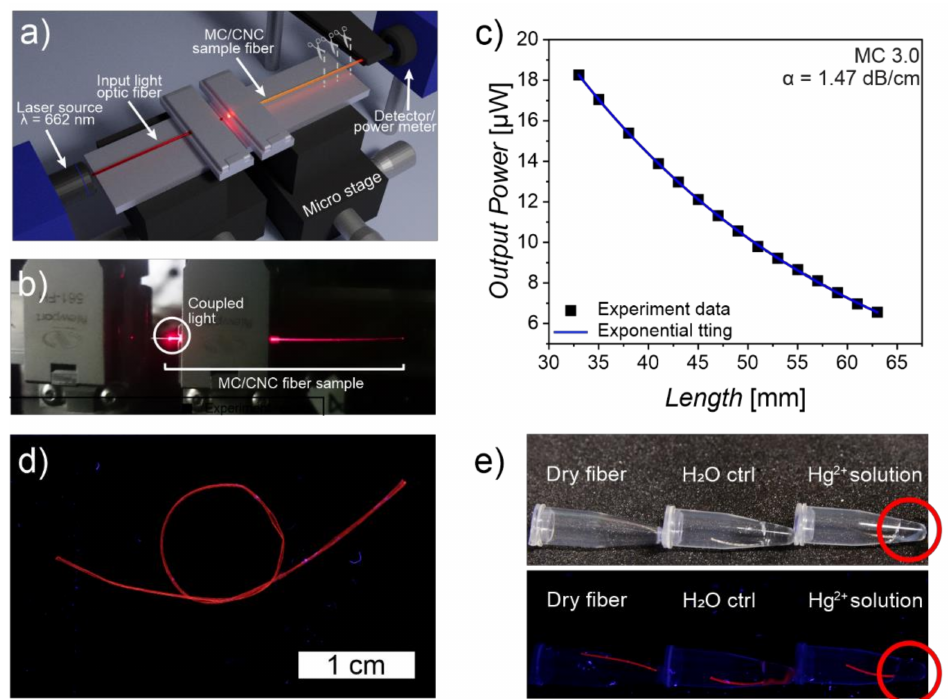
Figure 8. MC-based multifunctional optical fibers. ( a ) The attenuation of MC-based fibers has been studied with the cutback method, where the transmitted light intensity has been measured, the fiber shortened, and the measurement cycle repeated for several rounds. The results reveal signal attenuation per length of unit. ( b ) Photograph of an attenuation measurement system with an MC fiber coupled to a light source. ( c ) Representative attenuation measurement data (black circles) and mathematical fitting to the data (blue line). ( d ) MC fiber doped with gold nanoclusters (AuNC) is photoluminescent and shines red light upon UV irradiation. ( e ) AuNC-modified MC fiber as Hg 2+ sensor. Under UV light, the absorption of Hg 2+ ions (10 mM solution) into the MC-AuNC fiber quenches the luminescence providing a visual cue of the presence of Hg 2+ . The luminescence of a dry MC-AuNC fiber and a similar control fiber immersed in pure water remains unaltered. Adapted with permission from [36]. Copyright 2021 John Wiley and